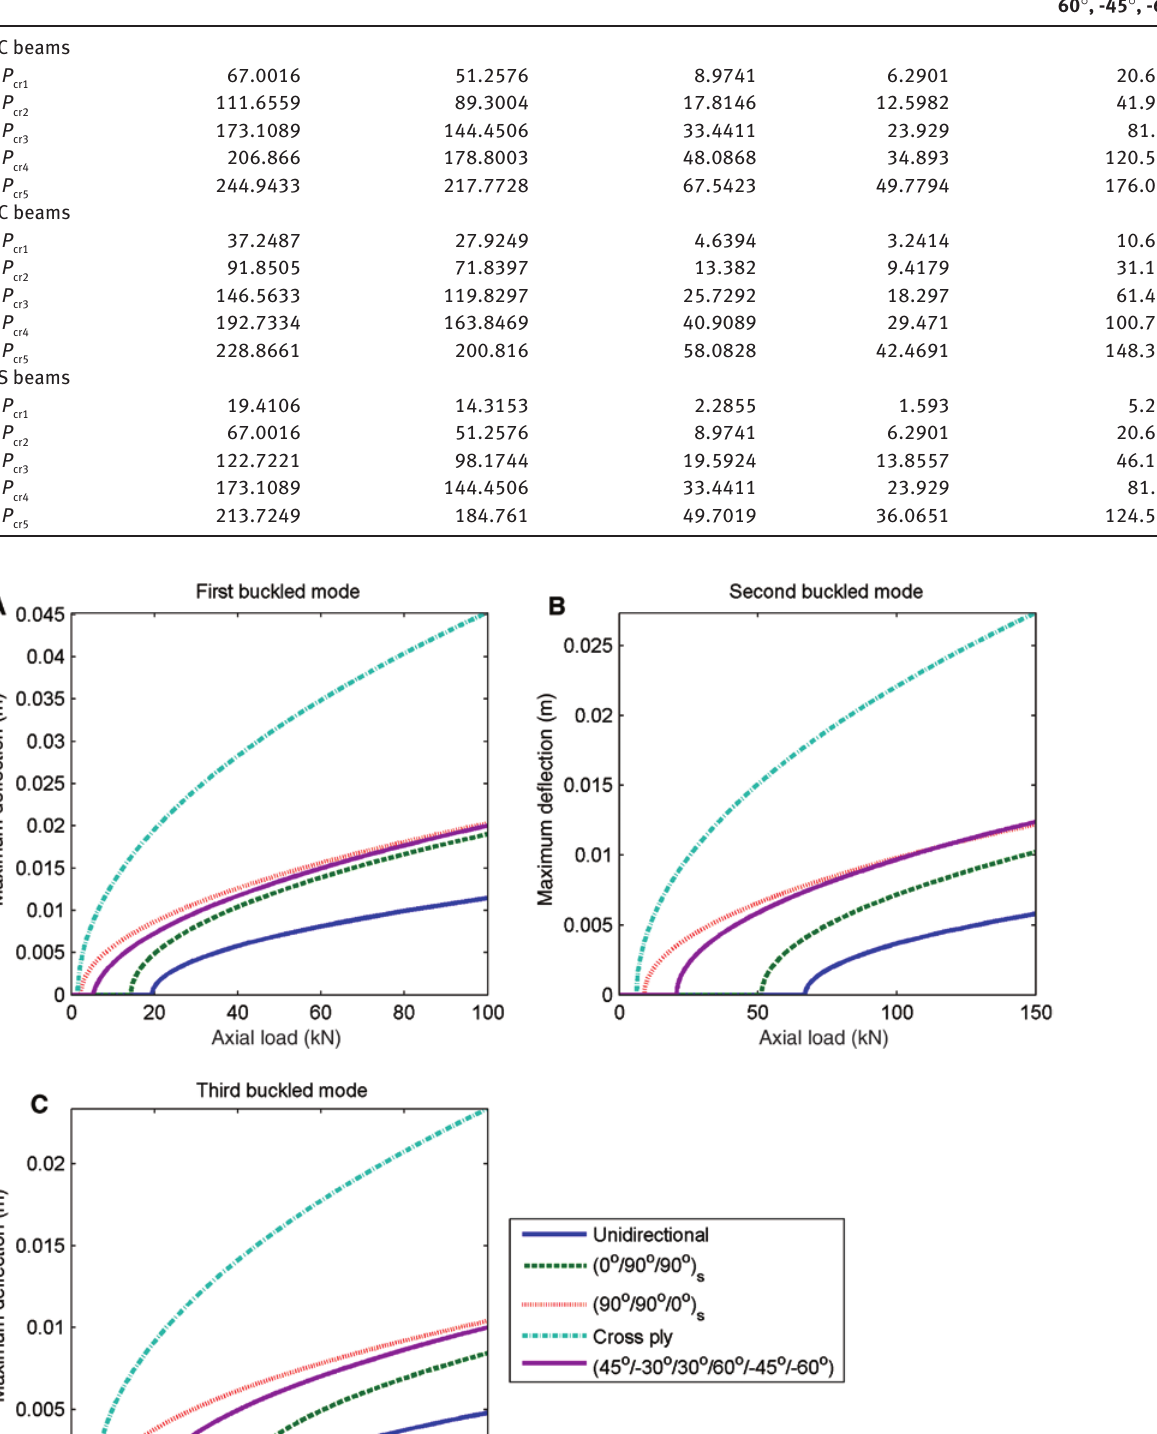
Table 2 First five critical buckling loads (kN) for different laminates of CC, SC, and SS beams ( L/h = 25). Laminate